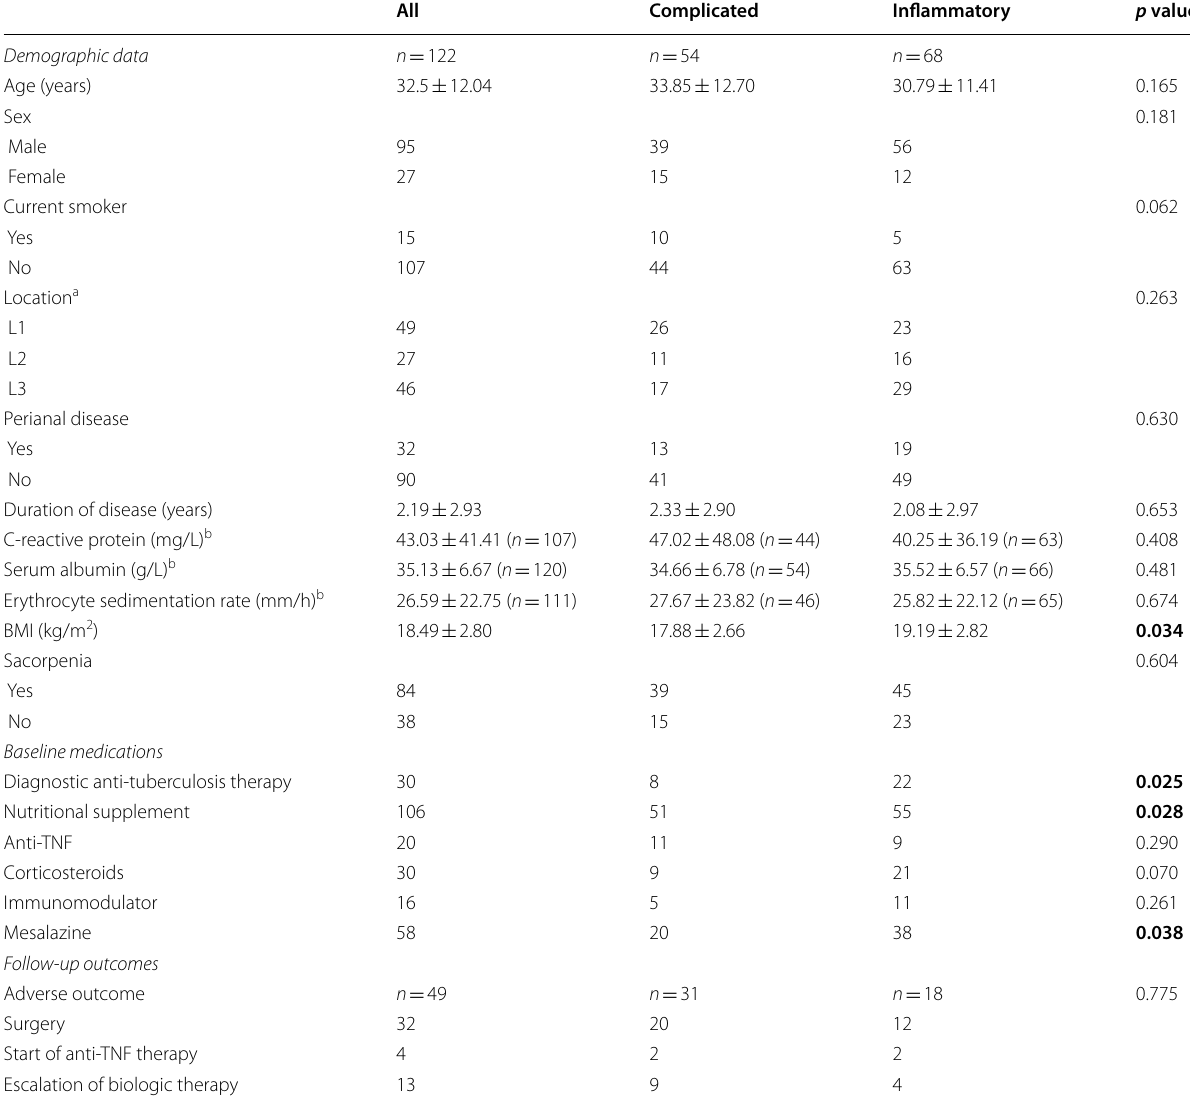
Table 1 Baseline characteristics of the study population, stratified by disease behavior